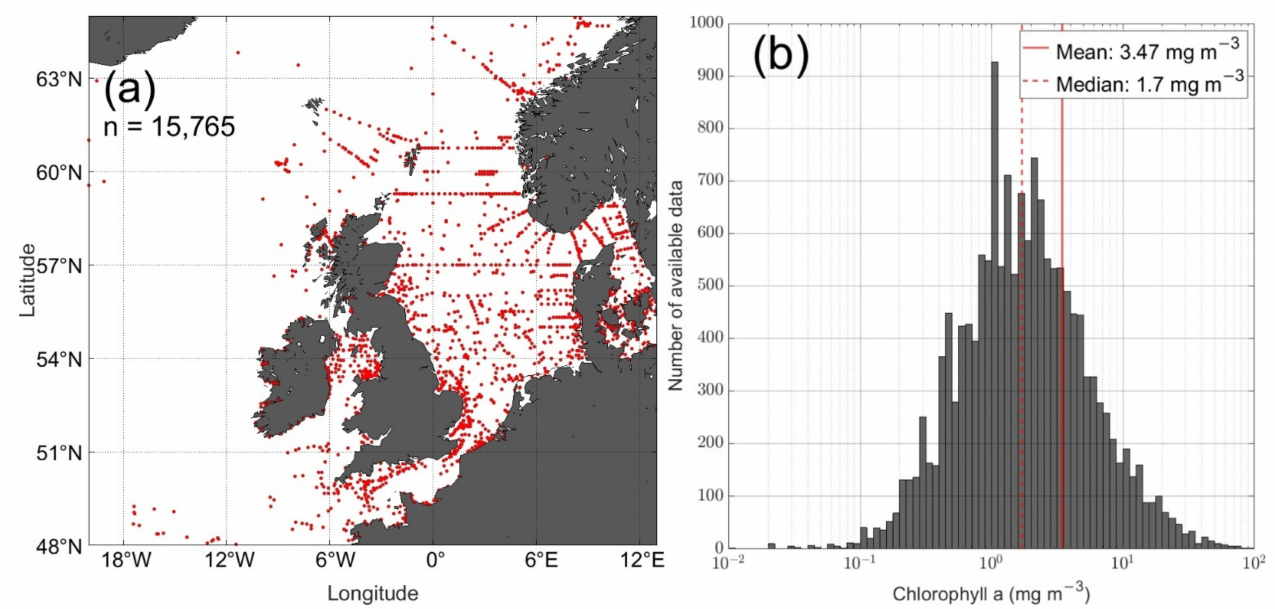
Figure 1. ( a ) Map of all matchup points available for the MODIS-Aqua sensor, July 2002 to January 2020, 0–10 m, averaged between 08:00 and 16:00. ( b ) Histogram of the in situ